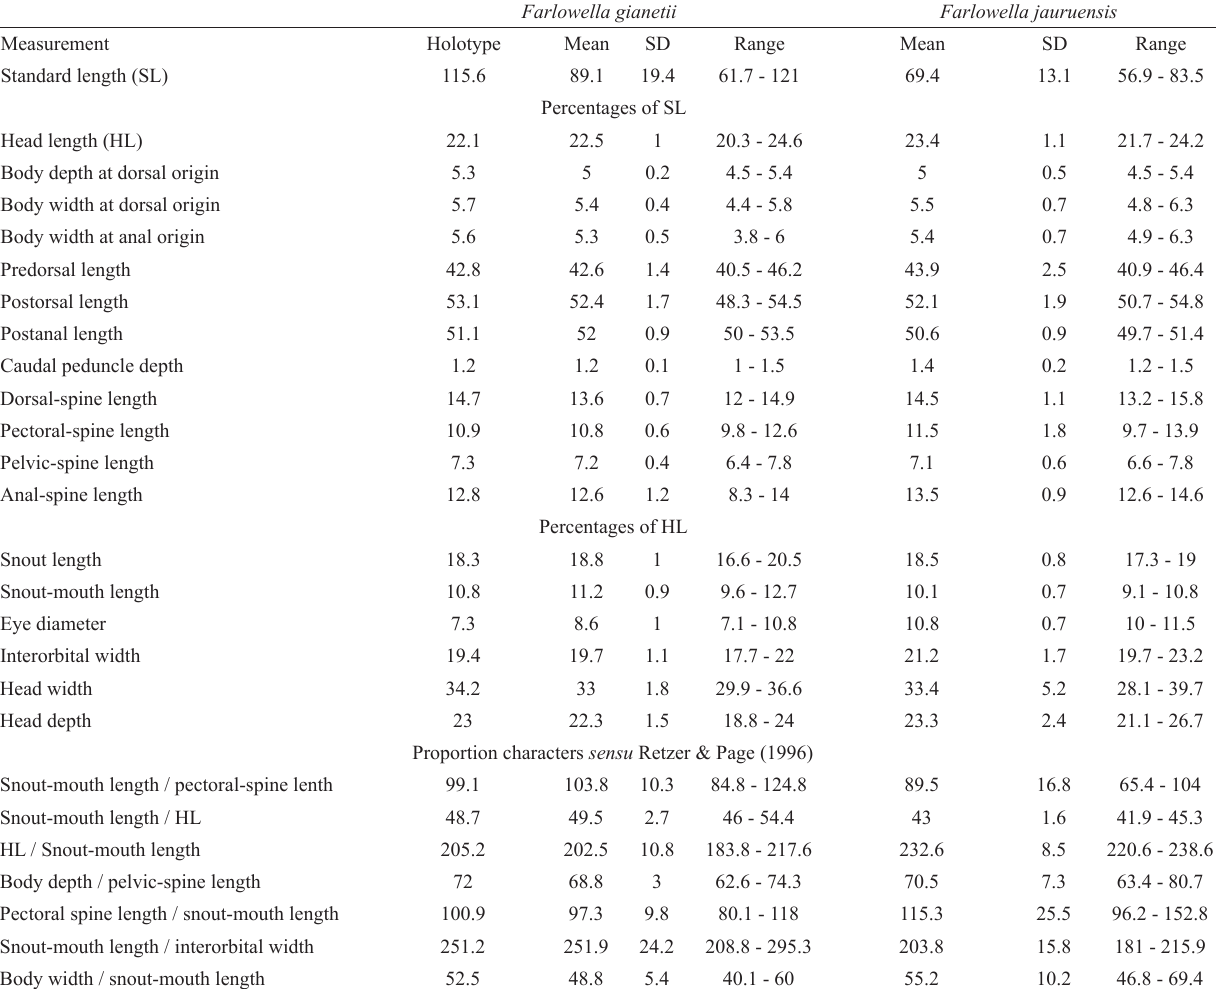
Table 1. Morphometric data for holotype and paratypes of Farlowella gianetii, new species